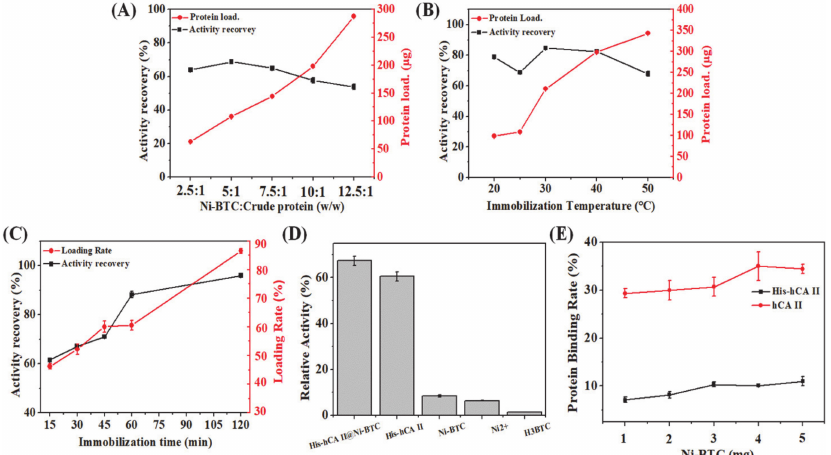
Figure 2. Optimizing immobilization conditions: ( A ) ratio of the carrier to enzyme; ( B ) immobilization temperature; ( C ) immobilization time; ( D ) the relative catalytic activity of His-hCA II @Ni-BTC, purified His-hCA II, Ni-BTC, Ni 2 + , H3BTC; ( E ) the protein binding rate of Ni-BTC to His-hCA II and hCA